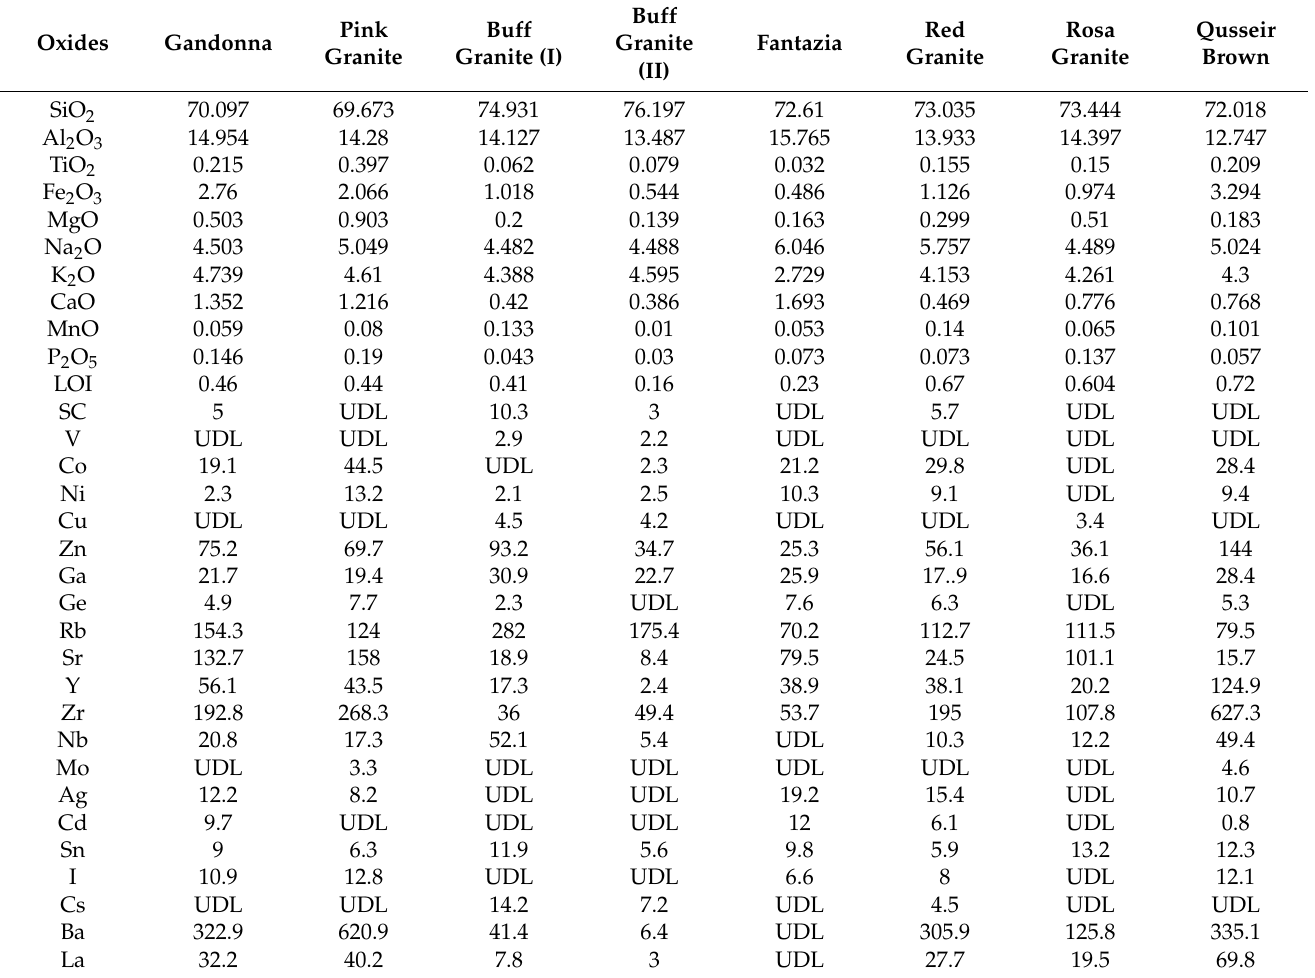
Table 2. Chemical composition [major (%) and trace elements (ppm)] of the studied granitic rock